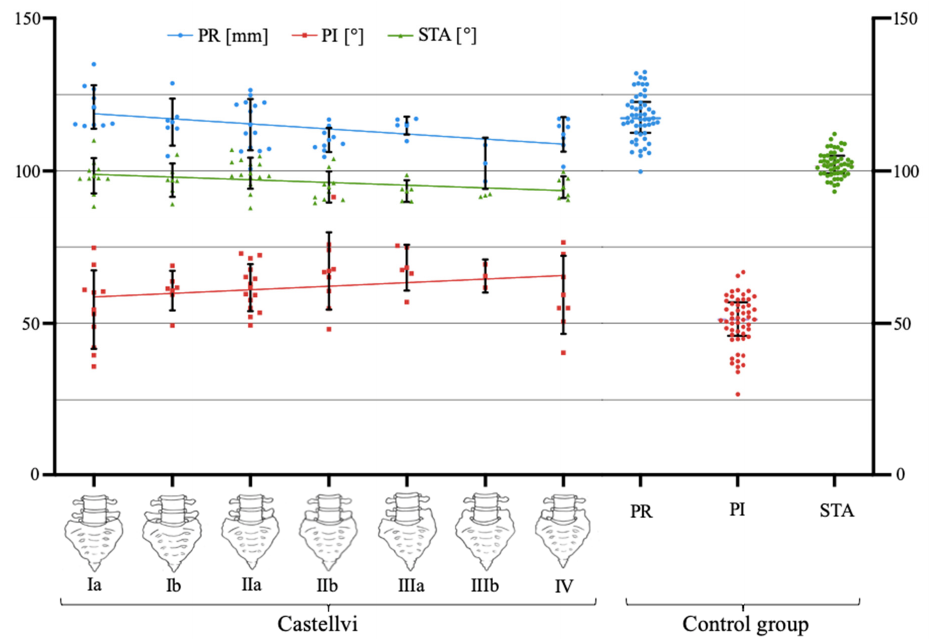
Figure 6. Relationships of PR (mm), PI, and STA (degree) with Catellvi classification and box-plotted values for PR (mm), PI, and STA (degree) in the control group.